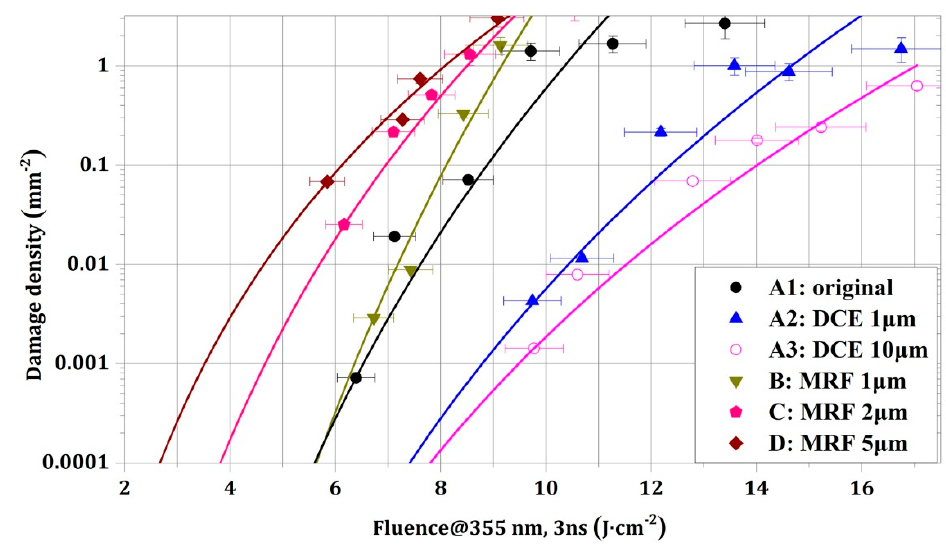
Figure 6. Damage densities versus fluence for all the fused silica samples. Damage fluence was rescaled to 3 ns pulse duration using 1/2 law. Table 3. Damage density of all fused silica samples at 8 J·cm − 2 fluences.